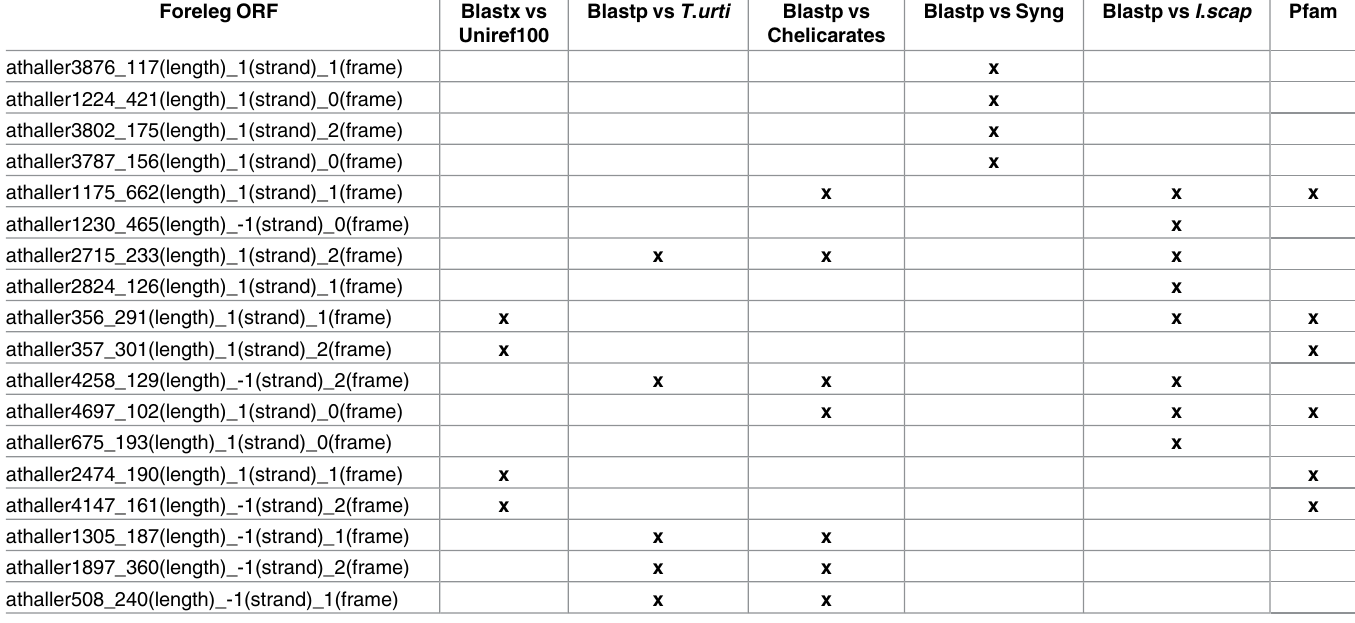
Blastp vs T . urti Blastp vs Blastp vs Syng Blastp vs I . scap Pfam Uniref100 Chelicarates